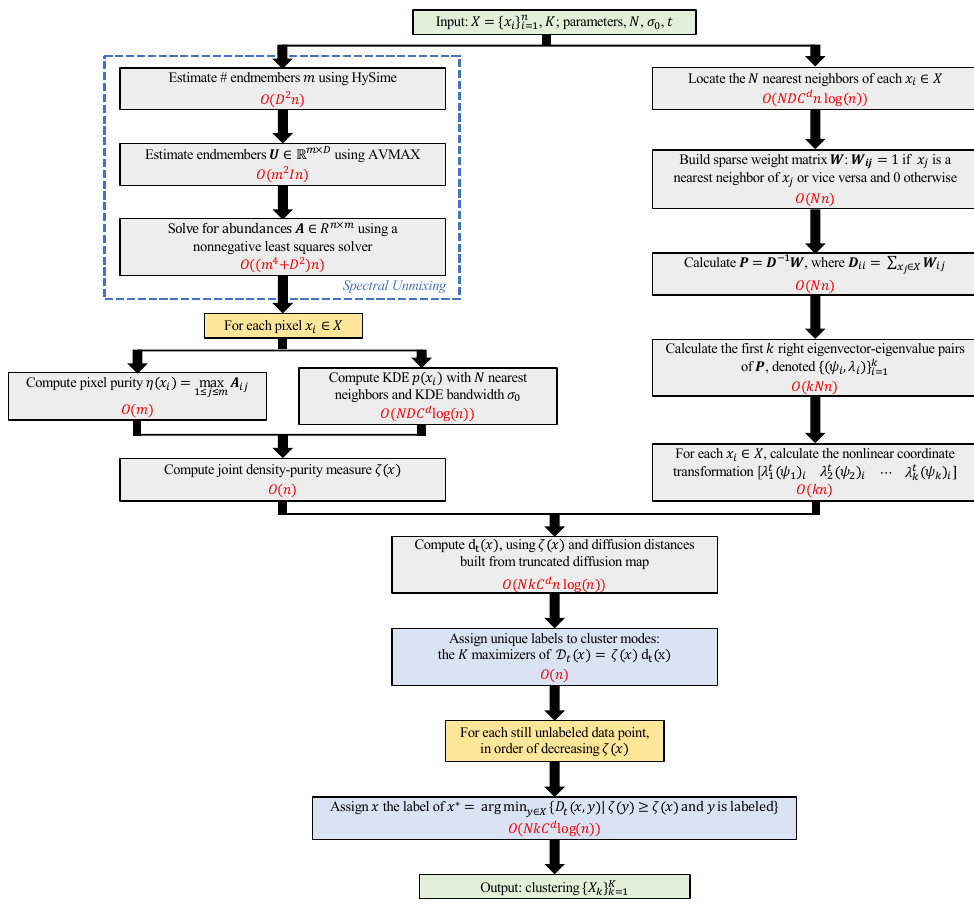
Figure 2. Diagram of the D-VIC clustering algorithm. The computational complexity of each step is colored in red. The scaling of D-VIC depends on n (no. pixels), D (no. spectral bands), m (no. endmembers), I (no. AVMAX maximizations), N (no. nearest neighbors), d (doubling dimension of X [136]), and C : a constant independent of all other parameters [136]; see Section 3.1 for